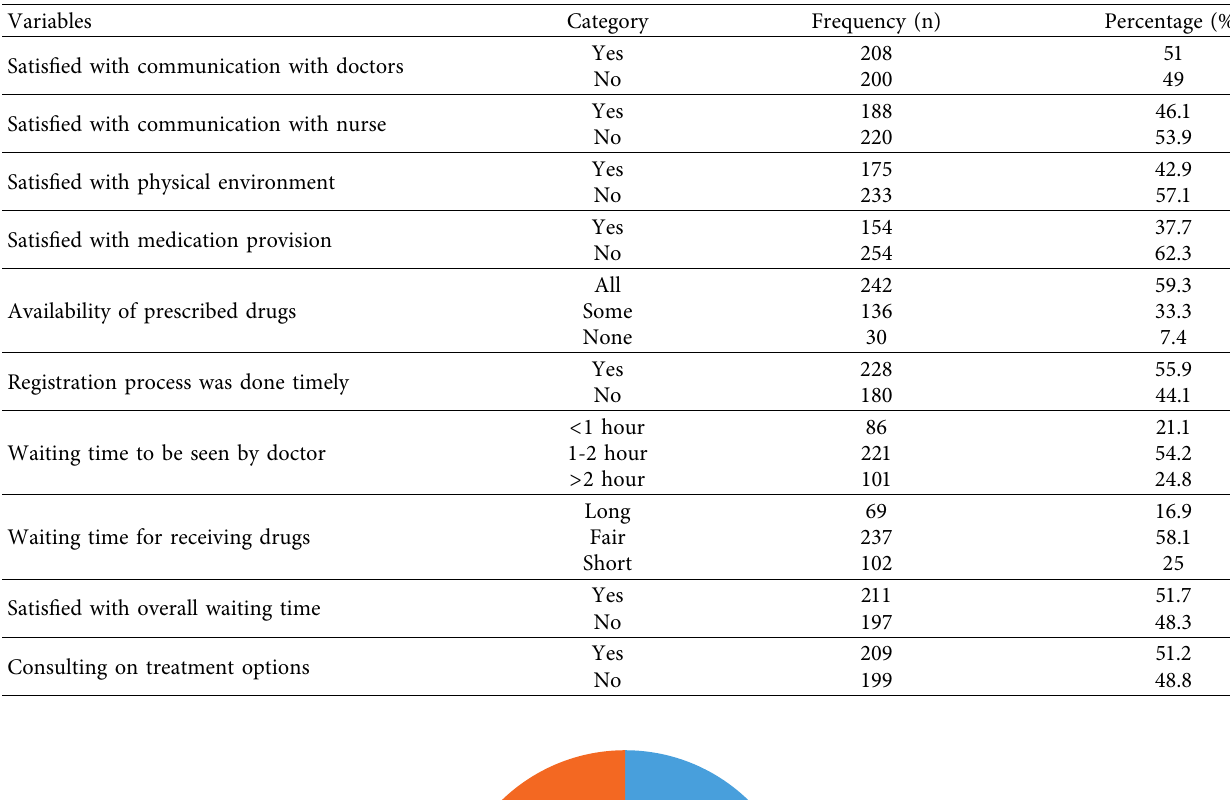
Table 2: Patient responses for organizational factors among outpatient health service users in North Gondar, Ethiopia, 2016 ( n � 408).